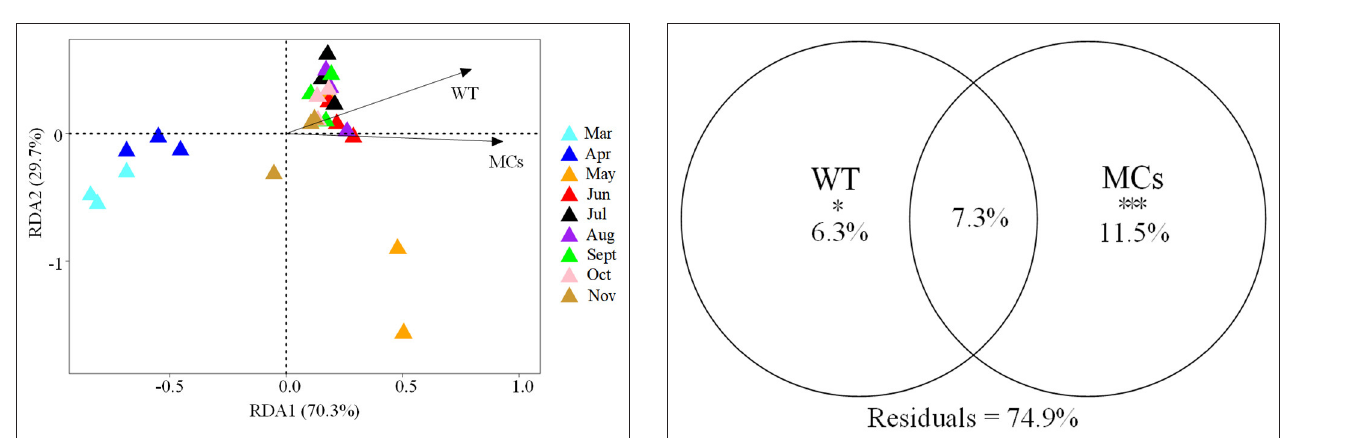
The pH ranged from 6.23 to 8.51 throughout the sampling period, with the maximal value in August and the lowest value in October. DO and SD varied from 1.49 to 9.14 mg/L and from 0.17 to 0.71 m, respectively. In general, the variations of NH 4 -N, NO 2 -N, NO 3 -N, and TN all initially decreased and then increased, and their minimal value of 0.04, 0.02, 0.28, and 0.52 mg/L, respectively, was observed in June and July. The trends of phosphate (PO 4 -P) and total phosphorus (TP) were similar, with variations ranging from 0.05 to 0.15 mg/L and 0.06 to 0.83 mg/L,